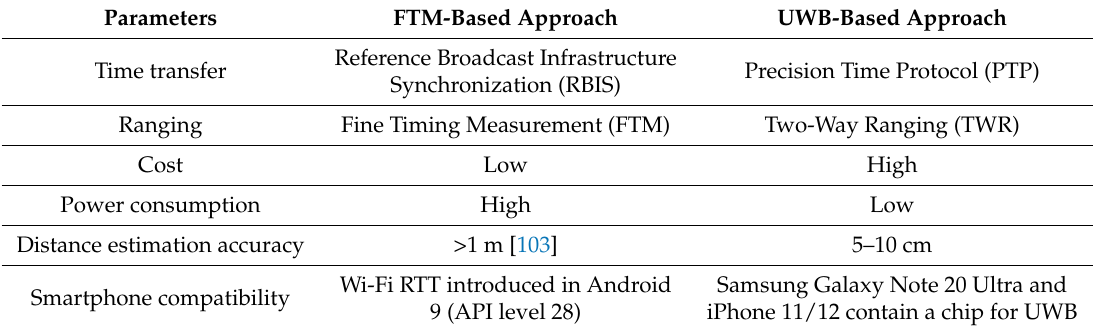
Table 2. Comparison of fine timing measurement (FTM)- and ultra-wideband (UWB)-based